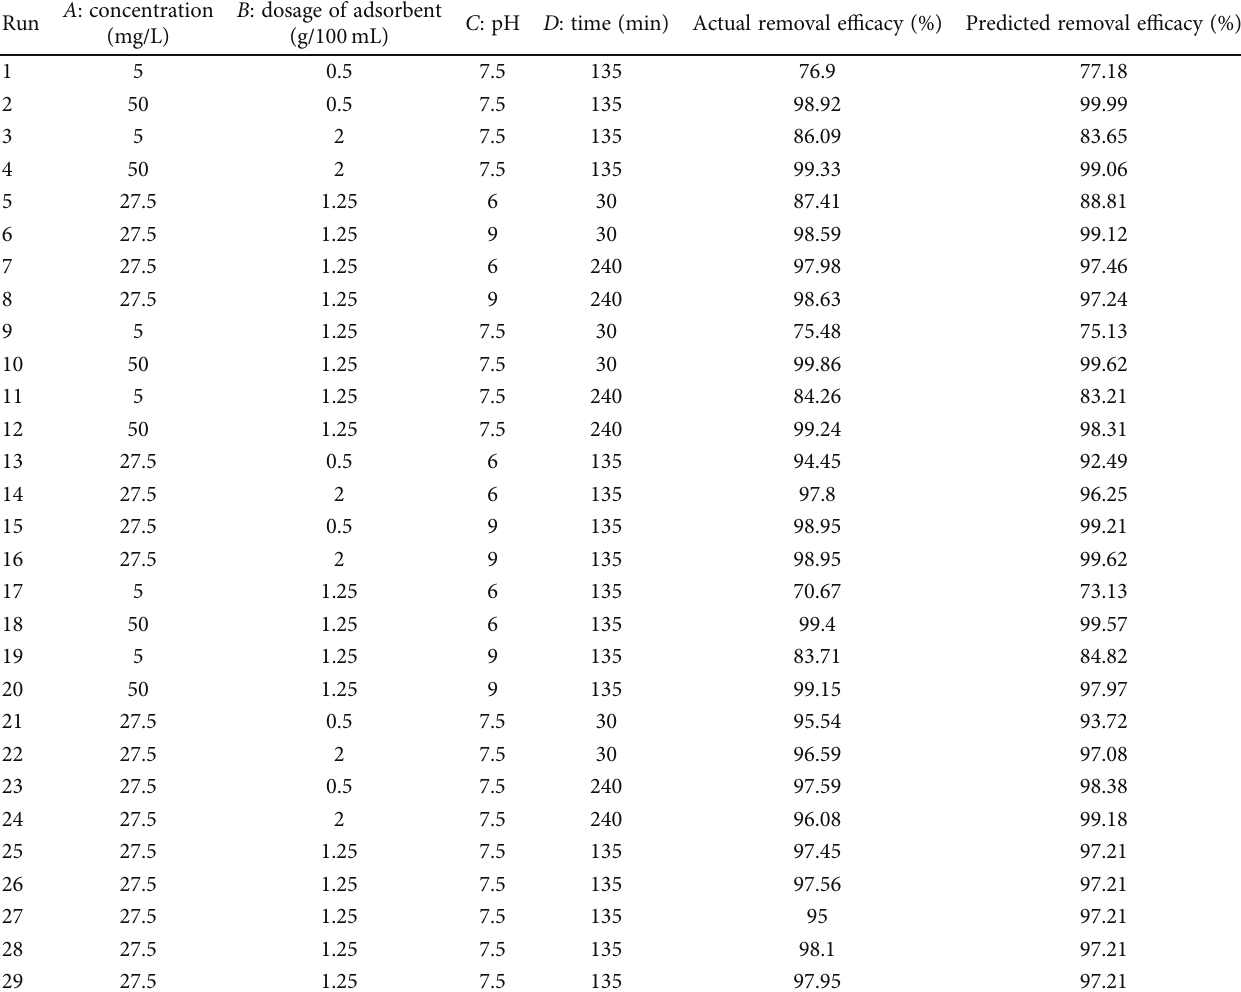
Table 3: Box-Behnken design (BBD) for adsorption of Congo red dye on breadfruit leaf biochar adsorbent. A : concentration B : dosage of Run (mg/L)